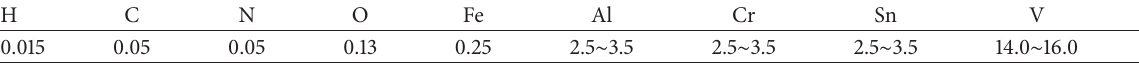
Table 1: Analyzed composition of the as-received Ti-153 sheets (wt.%).